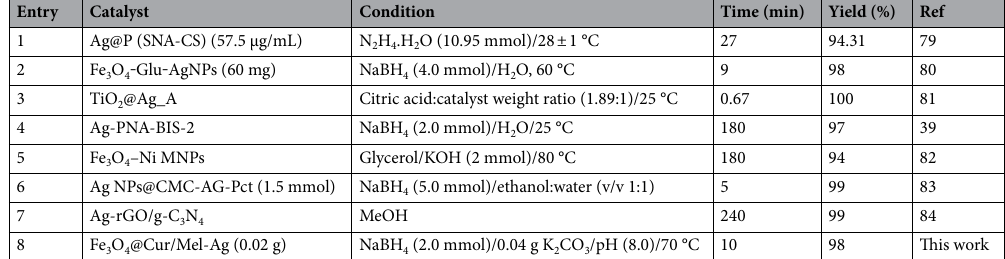
Table 3. Comparison of the obtained results in this study with some other reported catalysts.